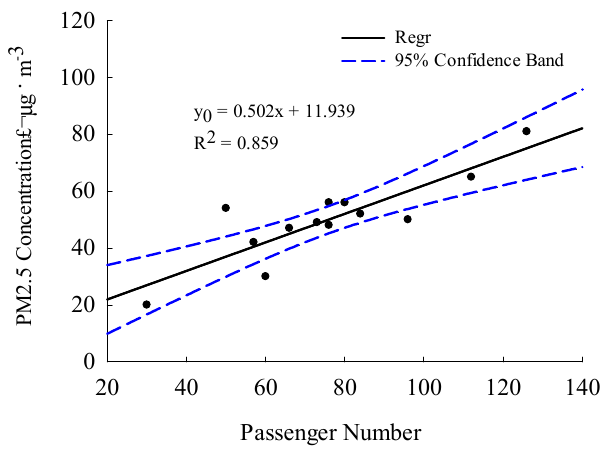
Figure 5. The relationship between passenger number and PM2.5 concentration.